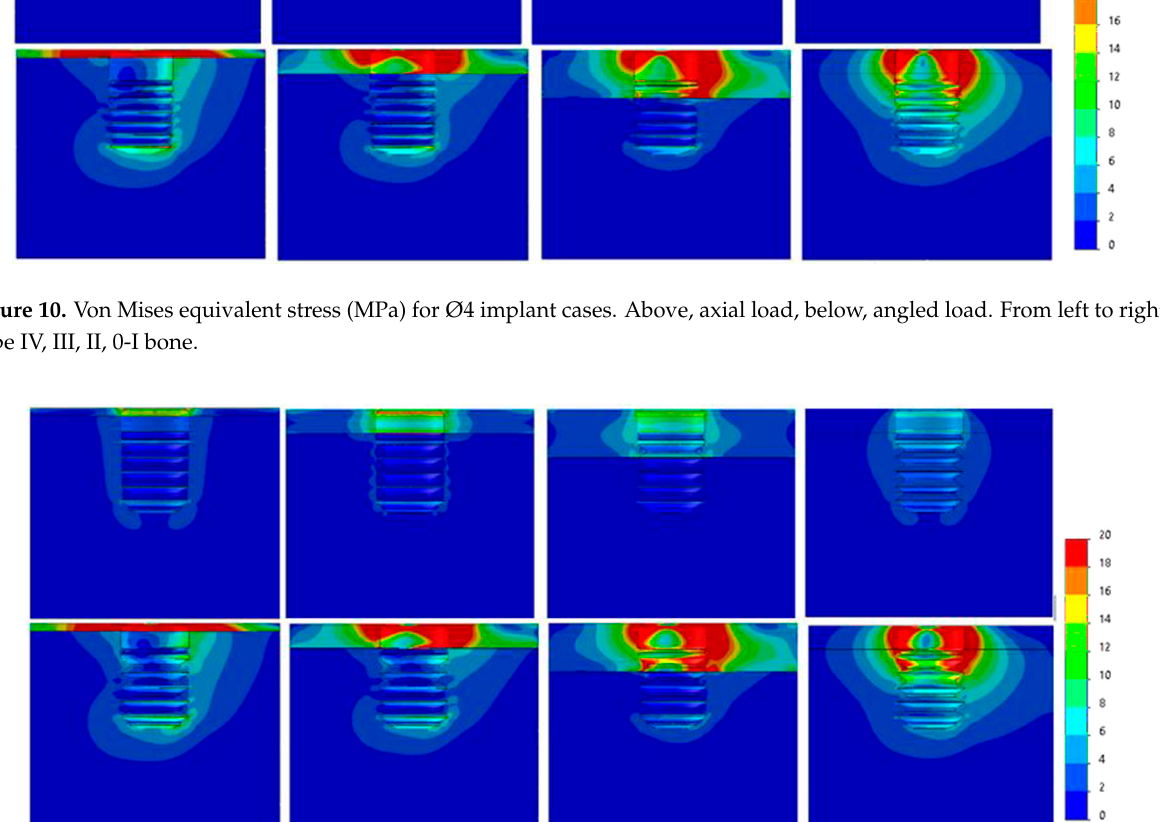
Figure 11. Von Mises equivalent stress (MPa) for Ø4.25 implant cases. Above, axial load, below, angled load. From left to right, Type IV, III, II, 0-I bone.